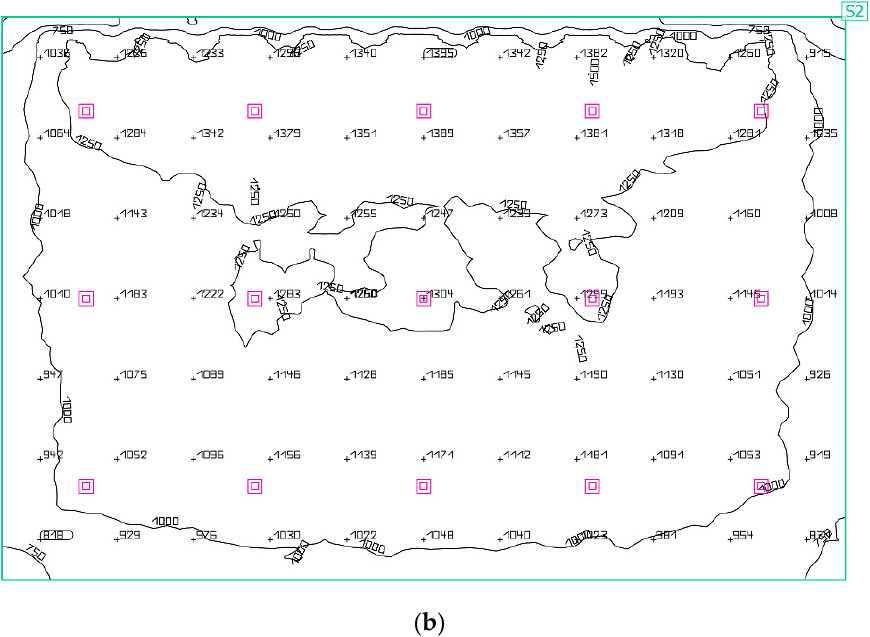
Figure 2. Light distribution profile of the room modelled by DIALux software: ( a ) In case of only daylighting, ( b ) In case of both daylighting and artificial lighting. Table 1. The lighting characteristic from simulation on experimental setup.